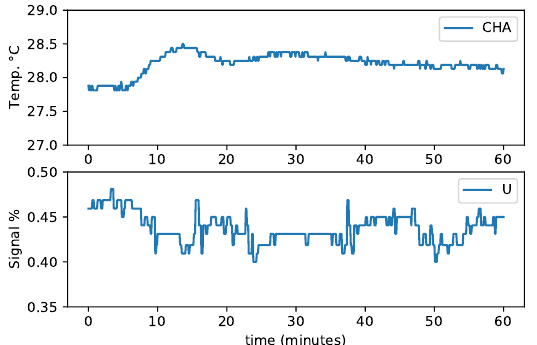
Figure 12. Results for control scenario (b) chamber focus which shows chamber temperatures close to set-point ( upper ) and control signal ( lower